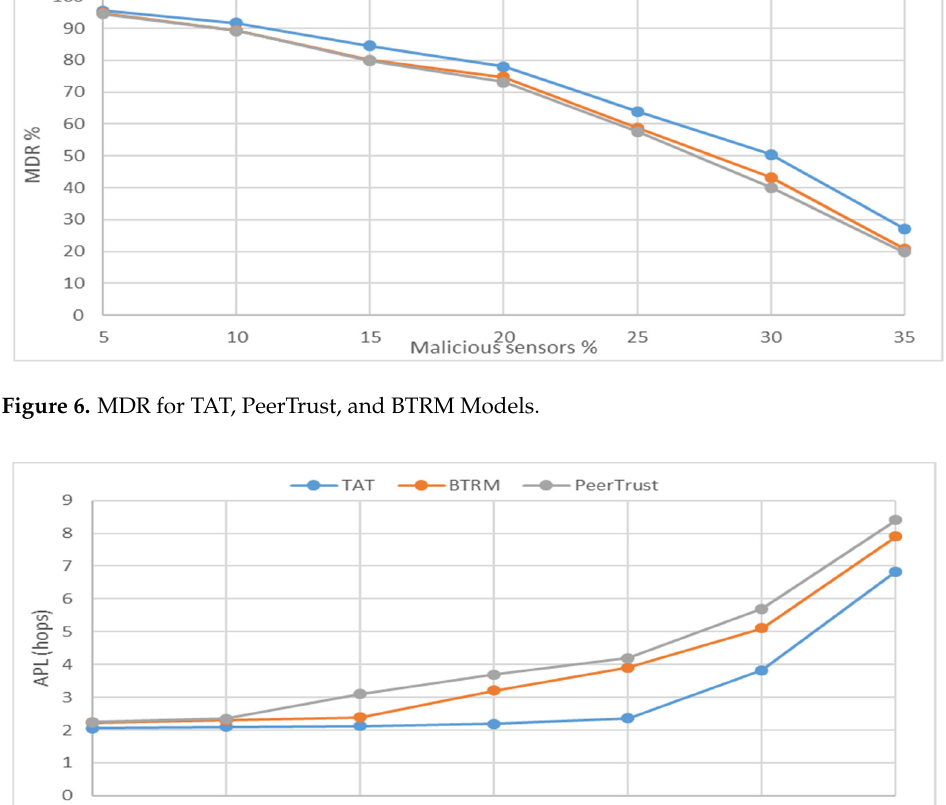
Figure 6. MDR for TAT, PeerTrust, and BTRM Models.